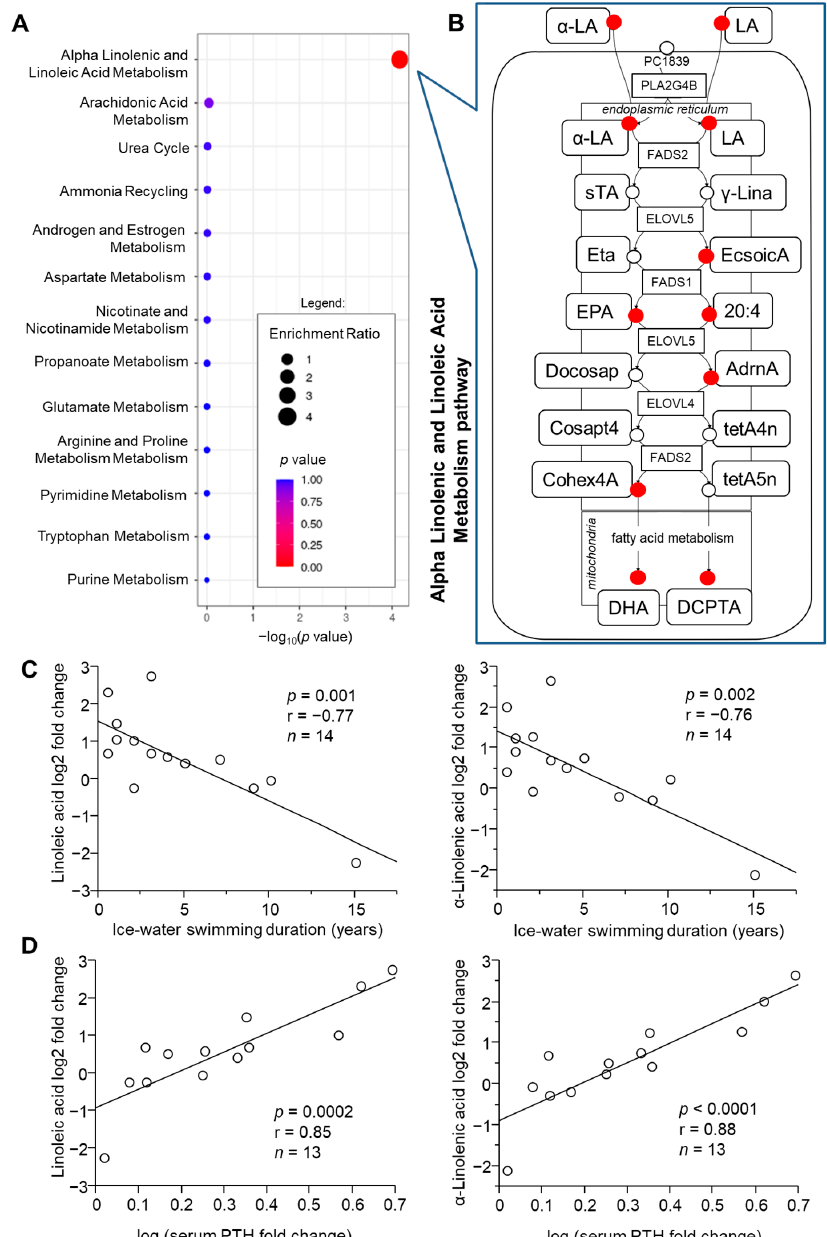
Figure 4. Cold-acclimatization level (ice-water swimming duration) is associated with individual changes in plasma metabolites, which are enriched in the α -linoleic ( α -LA) and linolenic acid (LA) metabolism pathway. ( A ) Over-representation analysis using metabolites correlating with the duration of ice-water swimming (Pearson’s linear regression p < 0.05) and ( B ) the detailed representation of the pathway taken from SMPDB 2.0 database (red circles—matched correlating metabolites with Spearman’s Rho < − 0.5). Cold-induced changes in α -LA and LA correlate with ( C ) the duration of the ice-water swimming habit and ( D ) with the cold-induced changes in circulating parathyroid hormone (PTH), analyzed by Pearson’s linear regression. sTA, Stearidonic acid; γ -Lina, γ -Linolenic acid; Eta, Cis-8,11,14,17-Eicosatetraenoic acid; EcsoicA, 8,11,14-Eicosatrienoic acid; EPA, eicosapentaenoic acid; 20:4, arachidonic acid; Docosap, docosapentaenoic acid (22n-3); AdrnA, adrenic acid; Cosapt4, Tetracosapentaenoic acid (24:5n-3); tetA4n, Tetracosatetraenoic acid (24:4n-6); Cohex4A, tetracosahexaenoic acid; tetA5n, tetracosapentaenoic acid (24:5n-6); DHA, docosahexaenoic acid; DCPTA, docosapentaenoic acid (22n-6).